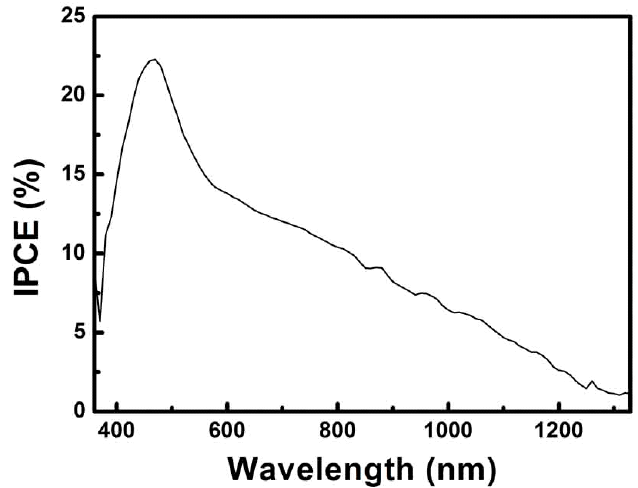
Figure 7. Incident photon conversion efficiency (IPCE) spectra of the CuInTe 2 nanocrystals PV device.